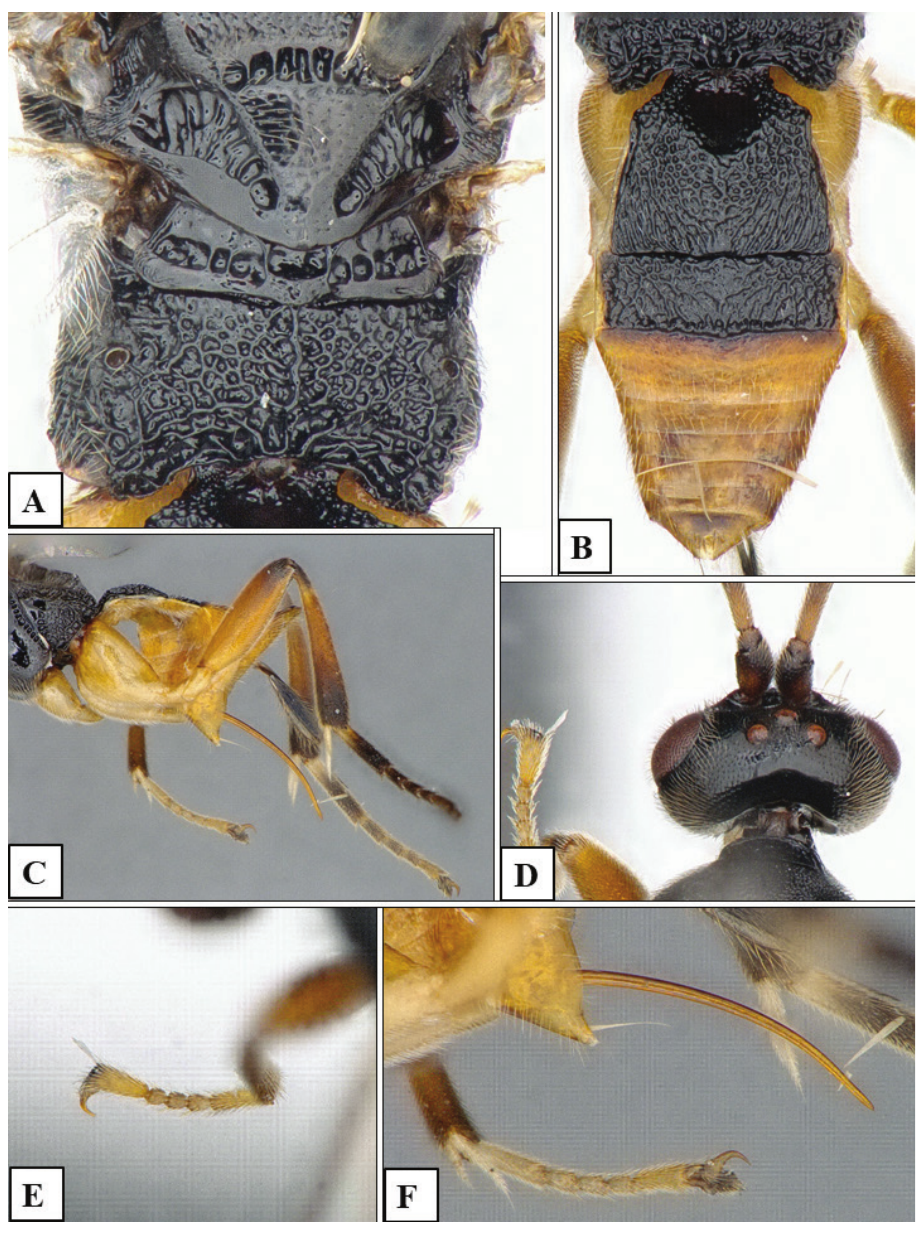
Figure 2. Microgaster godzilla , female holotype. A details of scutellar complex and propodeum B meta- soma, dorsal C metapleuron and metasoma, lateral D details of ocelli dorsal E tarsal claw F hypopygium and